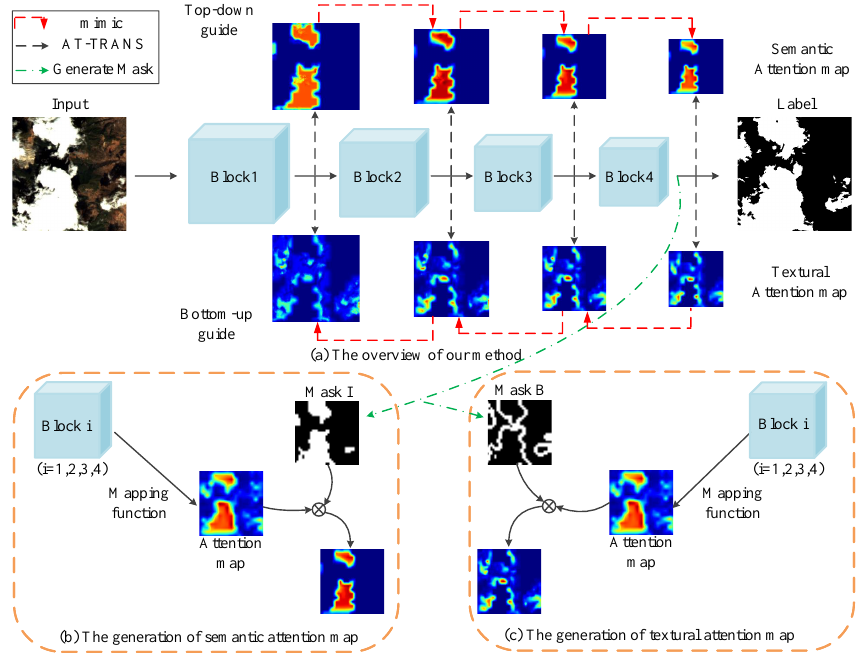
Figure 2. The pipeline of our proposed approach. ( a ) The overview of our Bi-SAD. ( b , c ) The details of the generation of semantic attention map and textural attention map. In panel ( a ), the black dotted line represents the generation of semantic attention map and textural attention map, the red dotted line represents the mimicking direction of Bi-SAD, and the green dotted line represents the generation of Mask B and Mask I